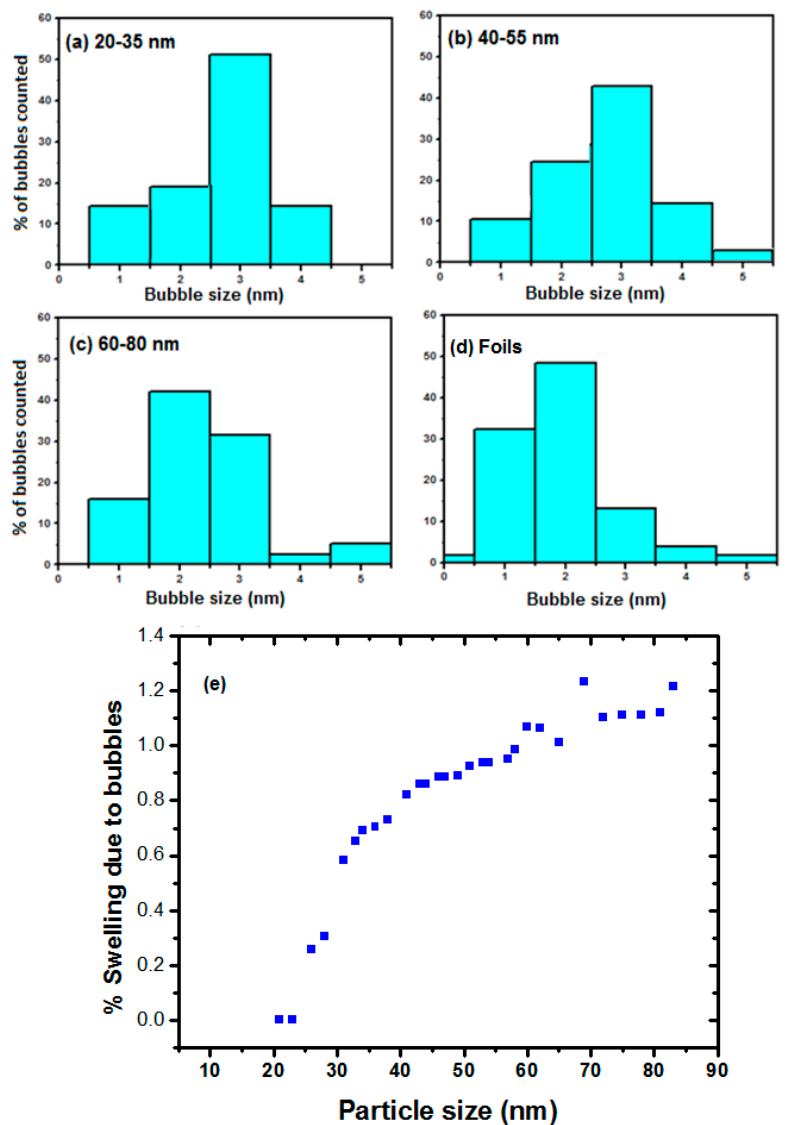
Figure 5. Distribution of bubble sizes in W irradiated with 15 keV He to a fluence of 1.1 × 10 17 ions · cm − 2 : ( a ) 20–35 nm NPs (sample = 80 bubbles in 20 NPs); ( b ) 40–55 nm (sample = 200 bubbles in 20 NPs); ( c ) 60–80 nm (sample = 280 bubbles in 28 NPs); and ( d ) the foils (sample = 280 bubbles). ( e ) Plot of the